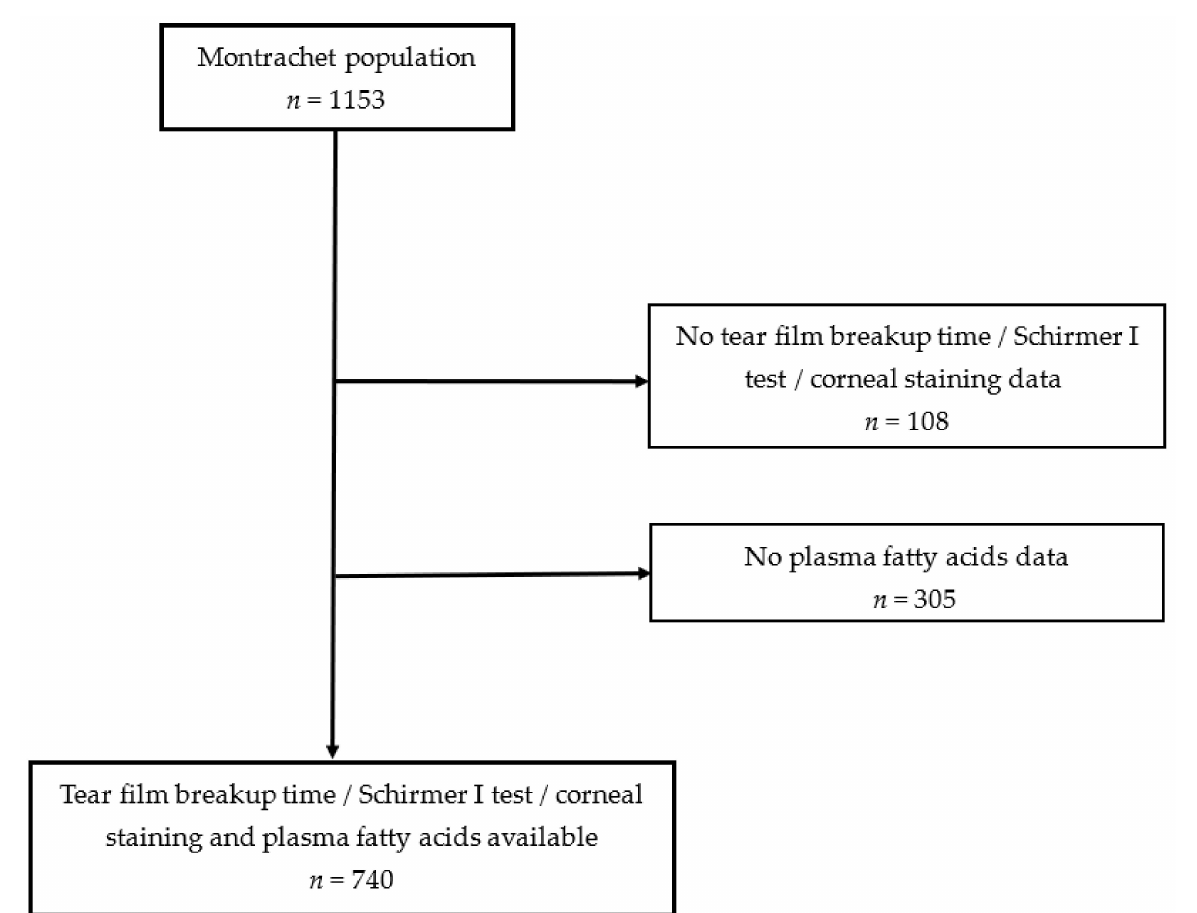
Figure 1. Workflow of fatty acids and dry eye disease in the Montrachet